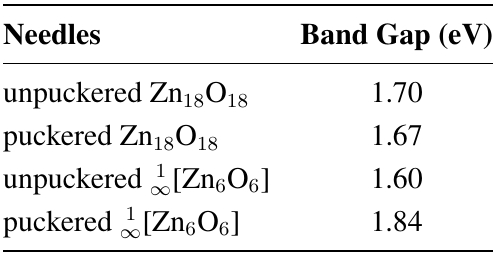
Table 3. Band gaps for finite and infinite needles that are based on either unpuckered or puckered building blocks. The infinite unpuckered needle shows an indirect band gap, while the infinite puckered needle shows a direct